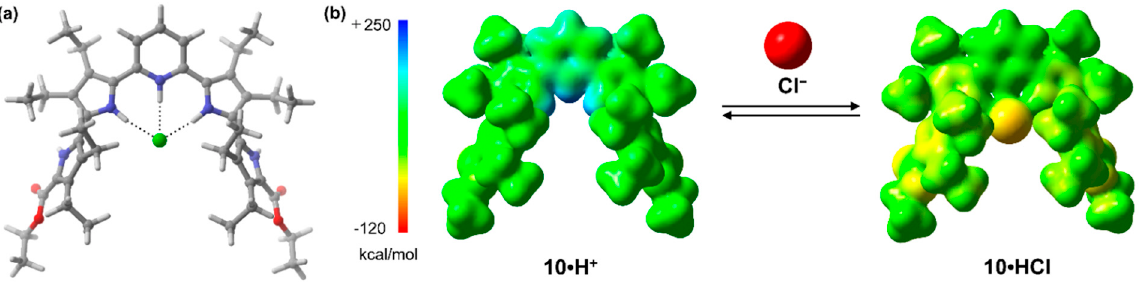
Figure 7. ( a ) Theoretically predicted energy-minimized receptor – acid complex [( 10 +H) + (Cl – )] in a gas phase. ( b ) The change in the electrostatic potential map (ESP) of the protonated receptor upon anion recognition.